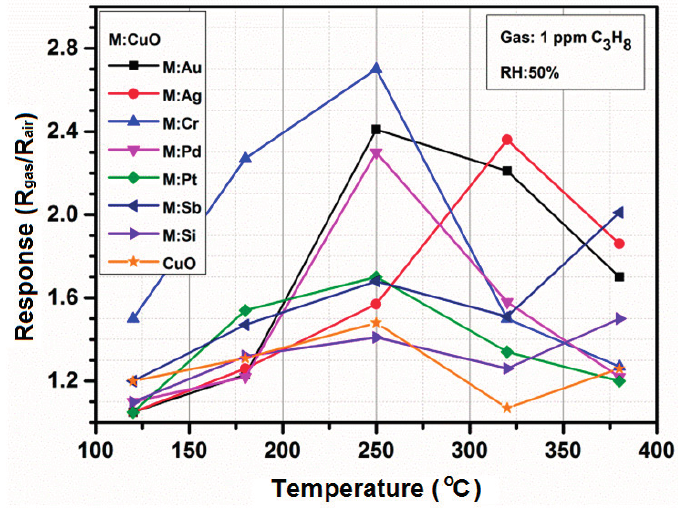
Figure 12. Gas response of the CuO- and M:CuO-based sensors (M: Ag, Au, Cr, Pd, Pt, Sb, Si) toward 1 ppm C 3 H 8 (RH: 50%) as a function of working temperature ranging from 120 °C to 380